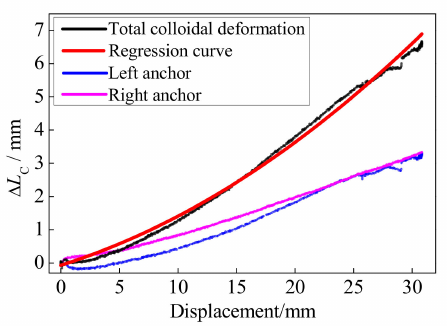
Figure 6. Anchor colloidal